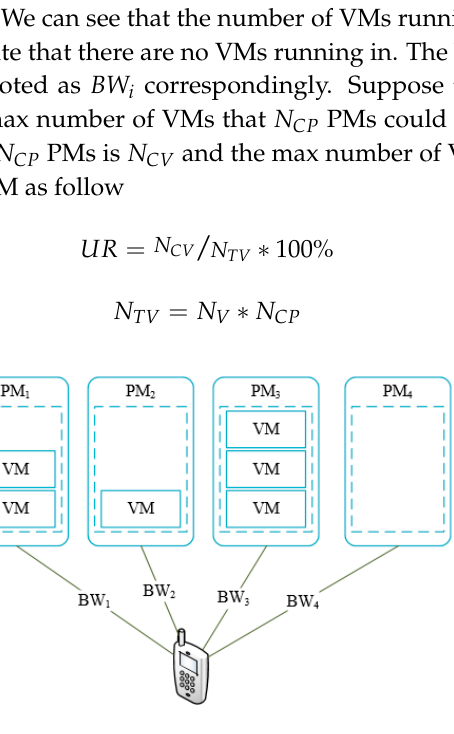
Figure 1. Allocation of physical machine.